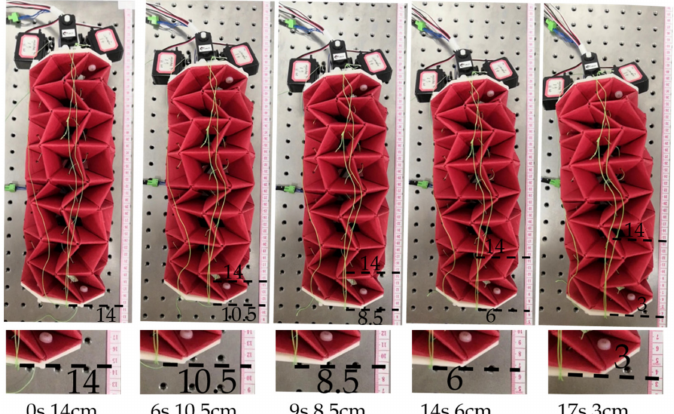
Figure 24. Top view of the backward motion of the crawling robot with electromagnetic sliding feet on an iron plane.